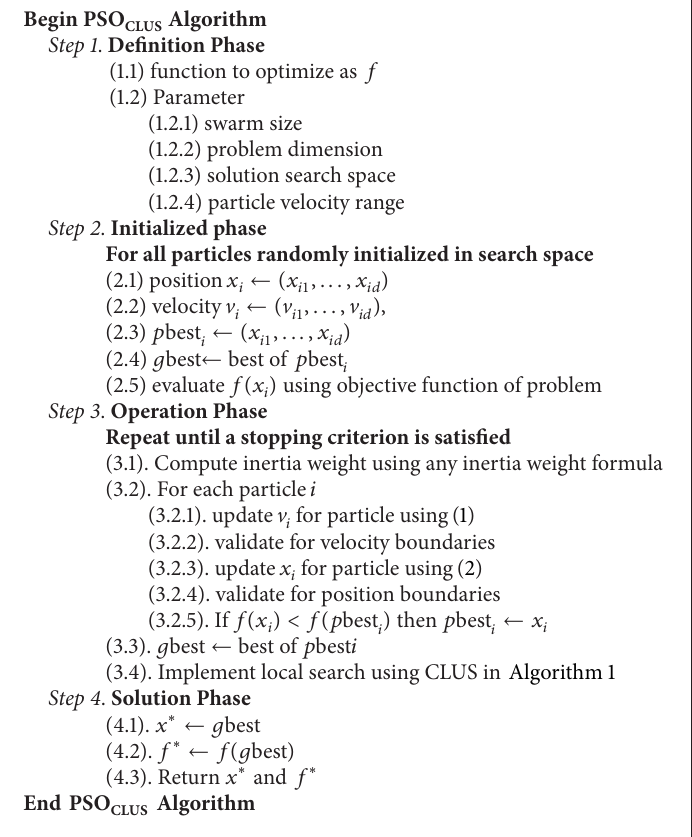
Algorithm 2: Algorithm for PSO